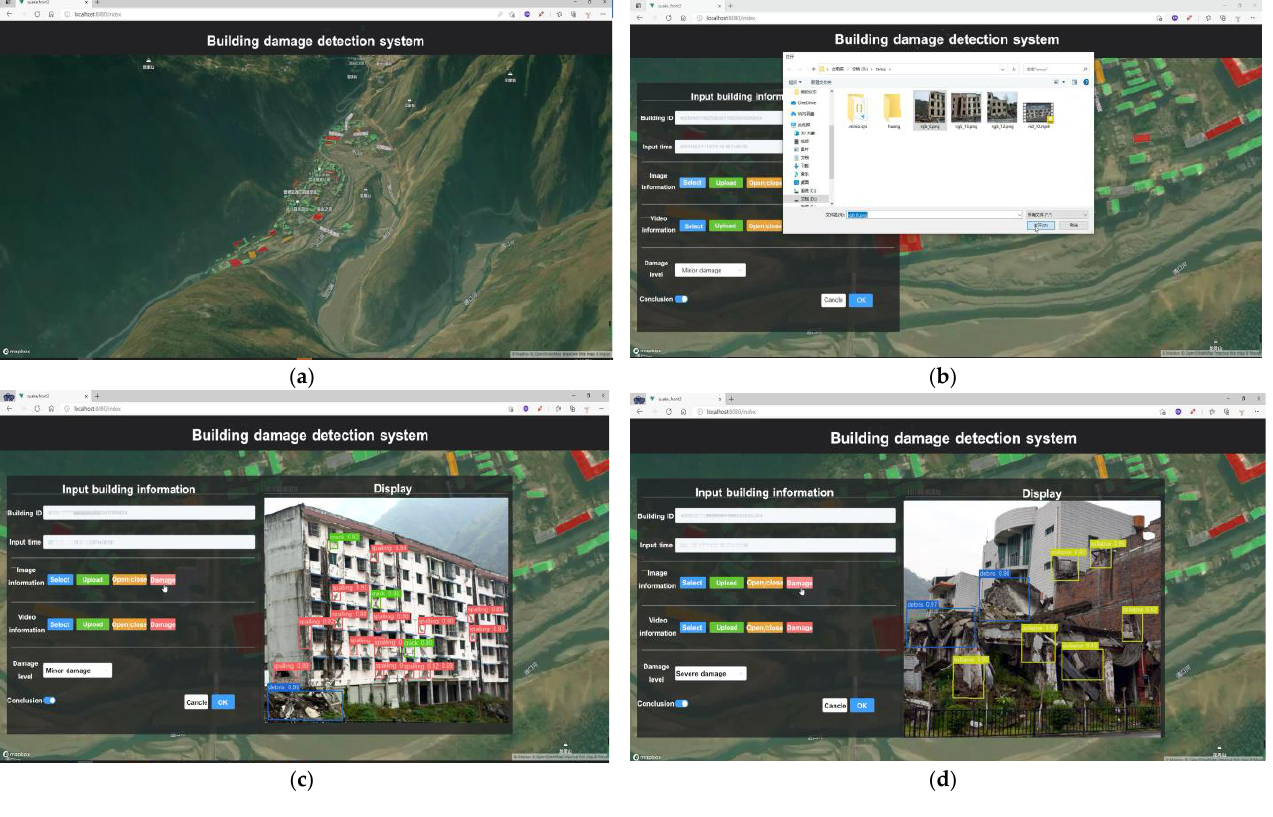
Figure 13. The main function of the building damage detection system. ( a ) 3D scene rendering, ( b ) building data uploading, ( c ) detection example of minor damage, and ( d ) detection example of severe damage.